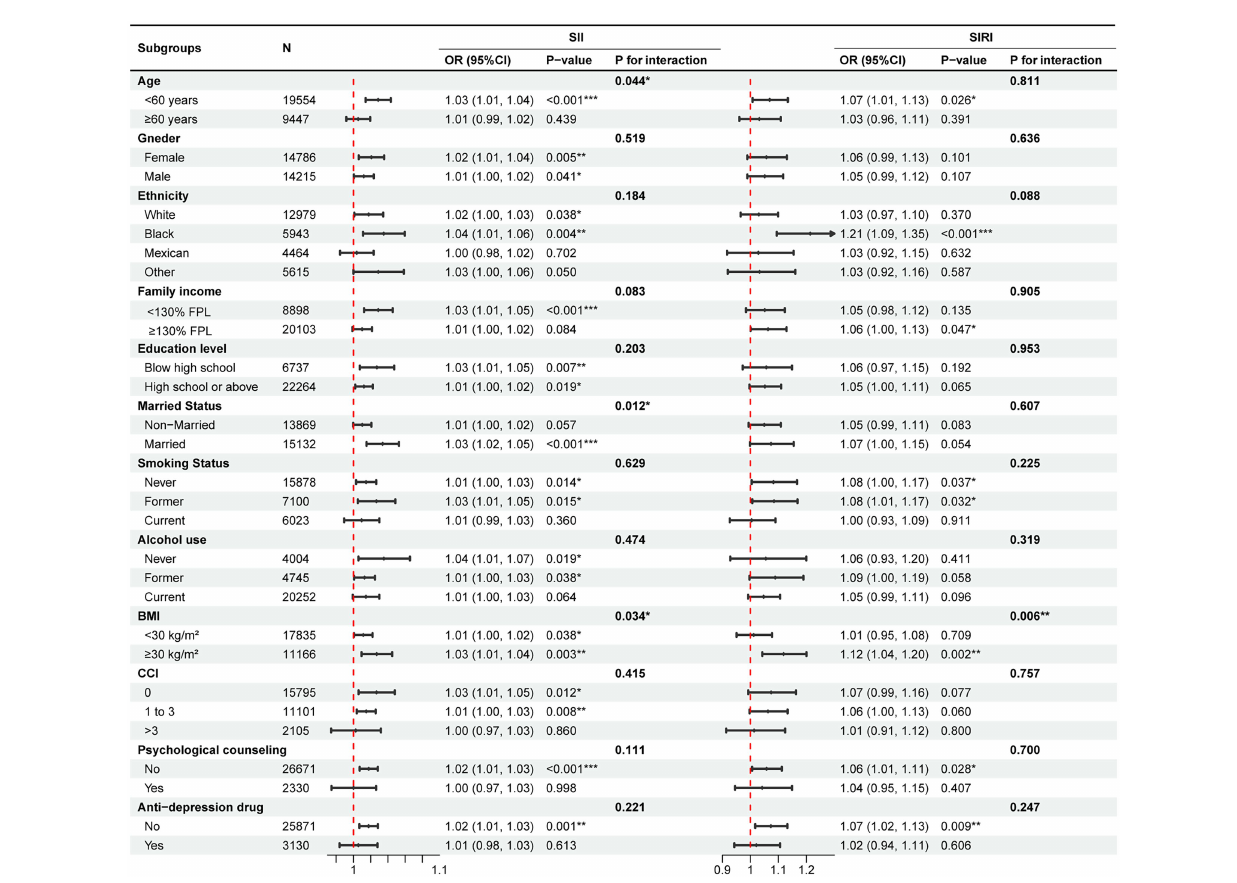
FIGURE 4 Subgroup analysis for the effect of SII and SIRI on depression risk. Adjusted for age, gender, ethnicity, education level, family income, education level, marital status, smoking status, alcohol use, psychological counseling, anti-depression drug use, BMI, and CCI except for the subgroup variable. FPL, federal poverty level; BMI, body mass index; CCI, Charlson comorbidity index; SII, systemic inflammatory index; SIRI, systemic inflammation response